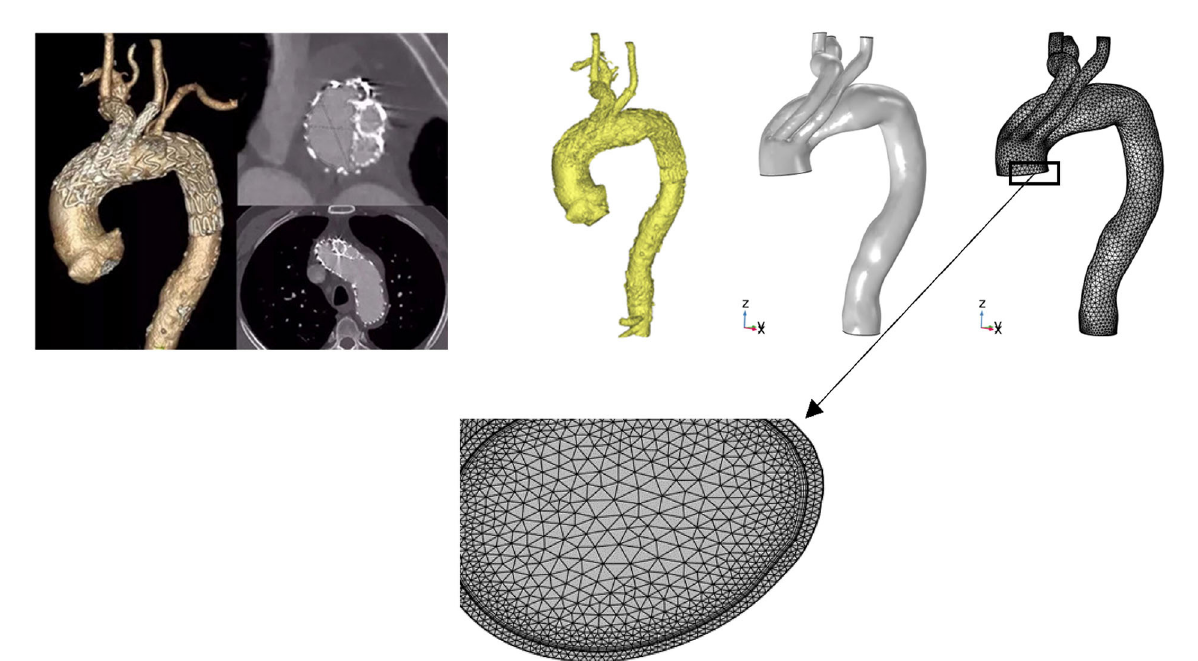
FIGURE2 Three-dimensional reconstruction and mesh generation of MIBSG in Case 4. The three-dimensional geometry was reconstructed from computed tomography angiography images using Mimics 19.0. The branches and aortic arch were separated and offset in 3-matic software to obtain the vascular wall. Commercial finite element method software (COMSOL 5) was used for the computation of the hemodynamic flow. To obtain mesh-independent solutions, 2,927,088 elements were used for Case 4. Although the laminar model used in all instances was reportedly able to capture the characteristic flow patterns in the aortic arch, six layers of boundary layer mesh were used to resolve the near-wall flow accurately. MIBSG, modular inner branched stent-graft.